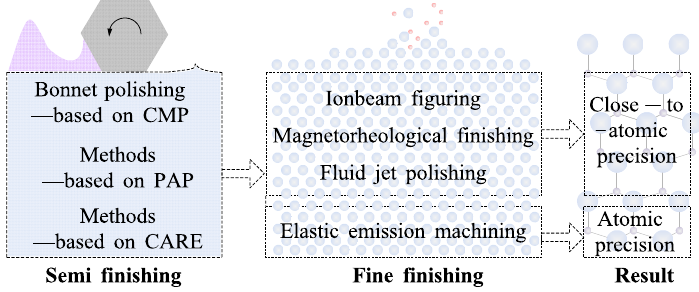
Figure 37. The processing chain for non-planar